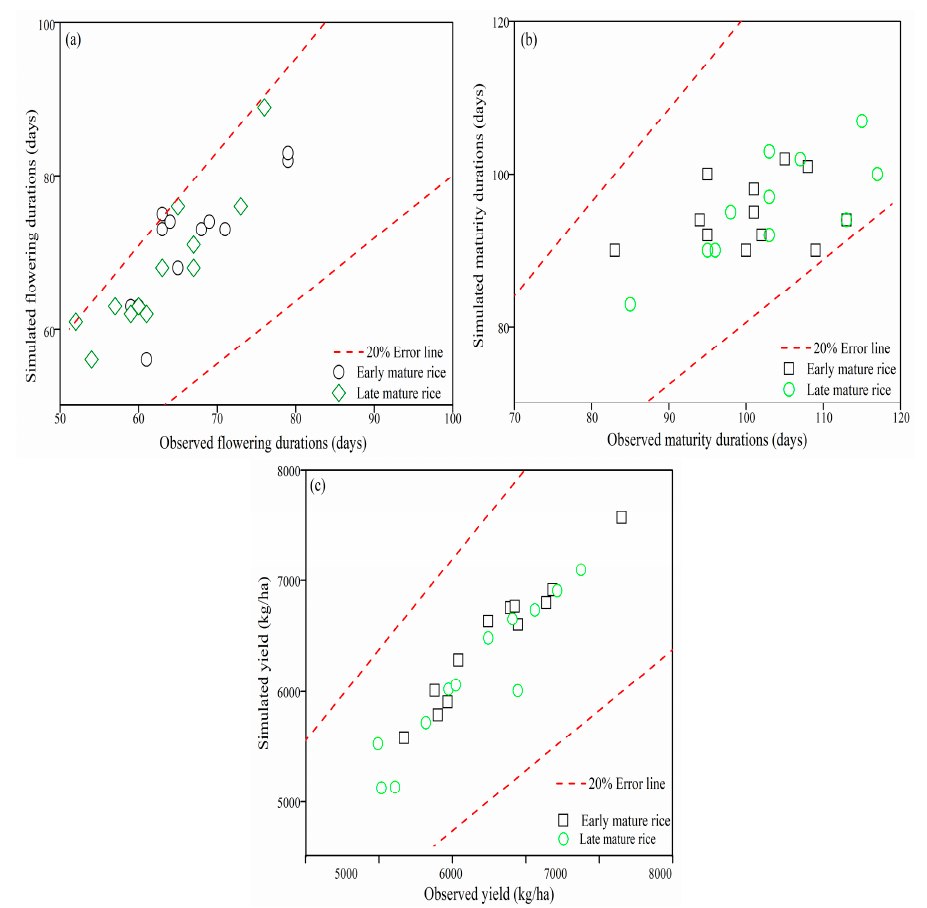
Figure 2. The calculated Normalized Root Mean Square Errors (NRMSEs) for early mature rice and late mature rice, respectively.